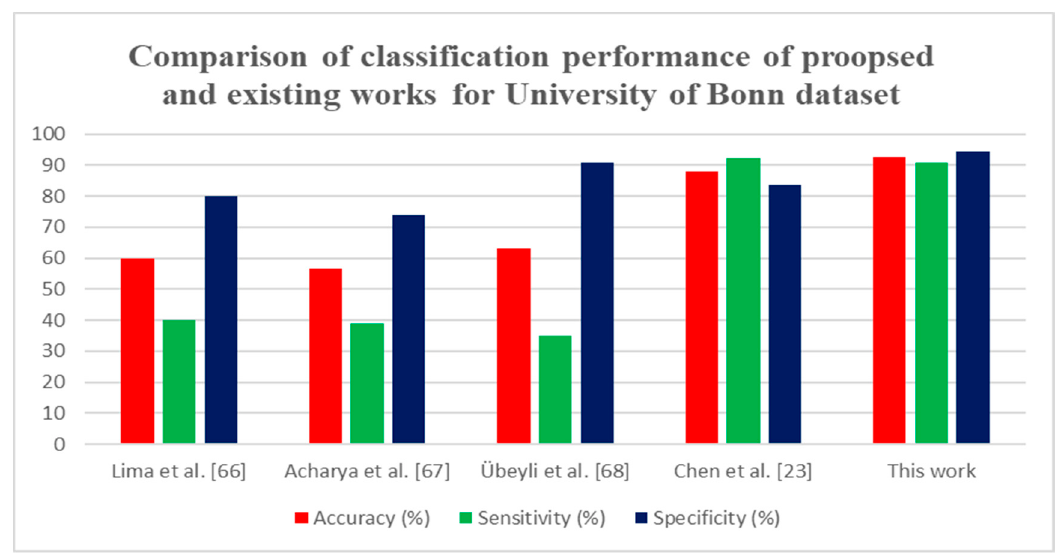
Figure 10. Comparison of classification performance proposed method with existing methods for the University of Bonn dataset.